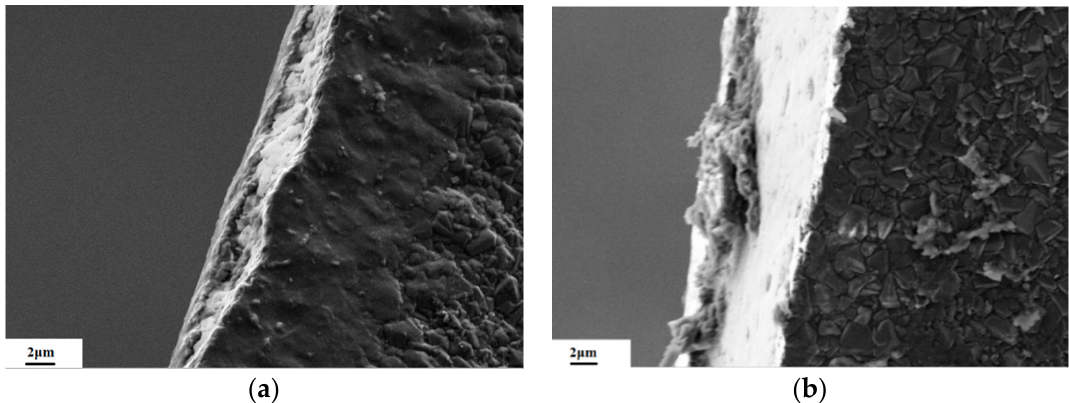
Figure 8. Worn morphology of cutting edge for MCD coated tools. ( a ) n = 4000 rpm, f = 0.004 mm/r; ( b ) n = 6000 rpm, f = 0.008 mm/r.